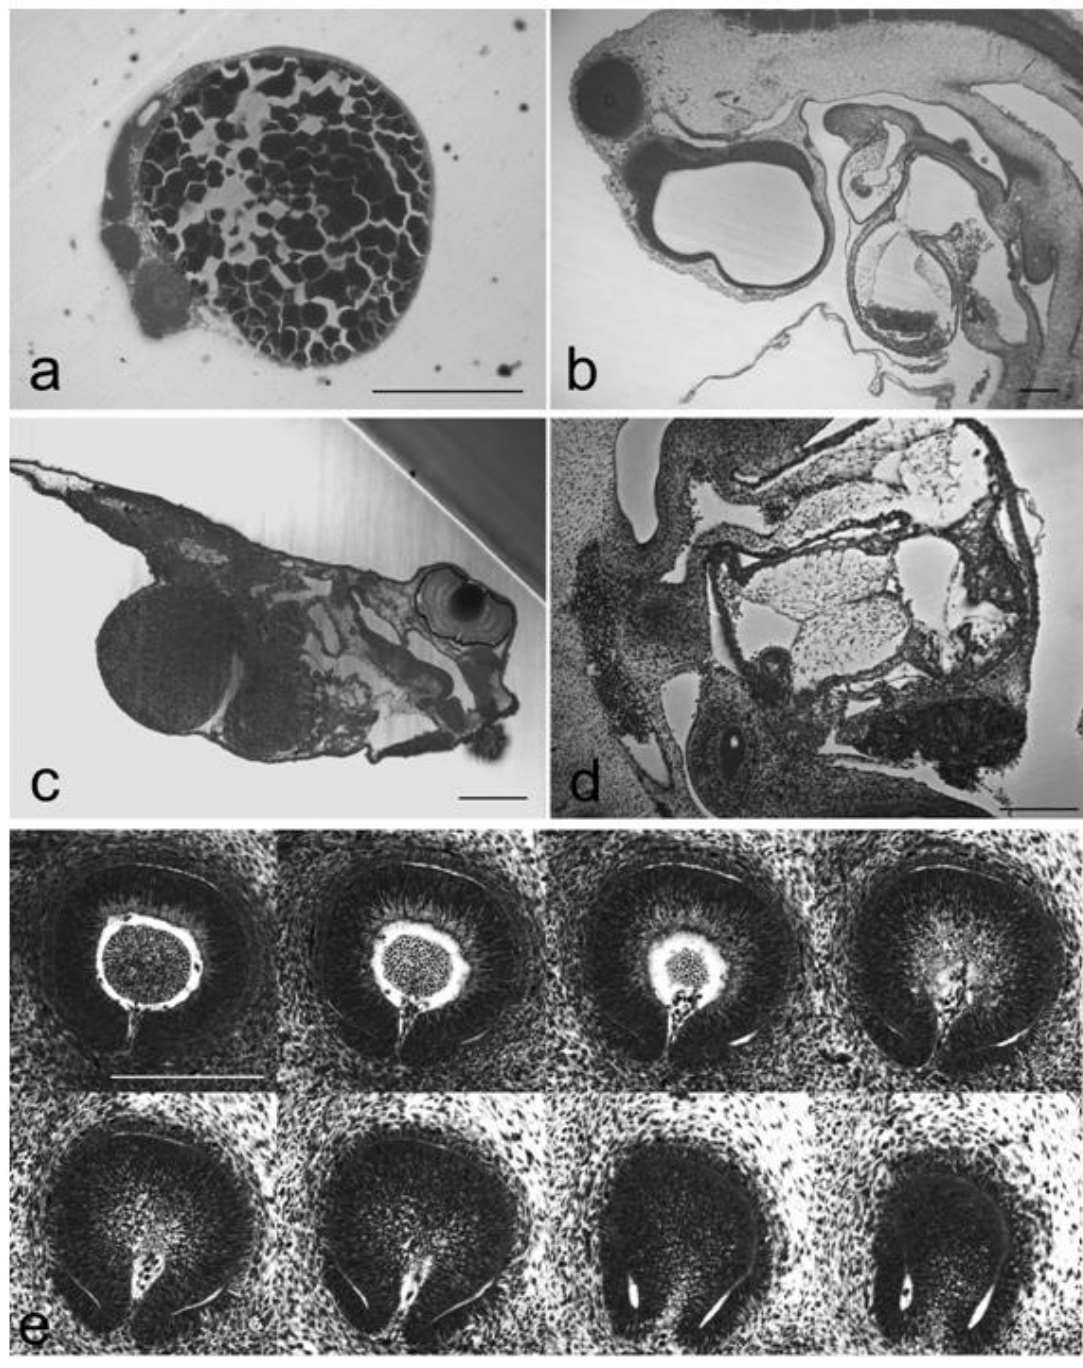
FIGURE 2. Digital images captured with HREM. (a) Zebrafish embryo (24–28 h); sagittal section. Note the voluminous yolk sac. (b) Heart and forebrain of a quail embryo (HH20); sagittal section. (c) Xenopus embryo (developmental stage 41); oblique section. (d) Heart of a mouse embryo (TS 16); sagittal section. Note the endocardial cushions. (e) Series of HREM images of sections through the eye of a mouse embryo (TS 16). Note that not all sections of the series are displayed. Scale bar, 200